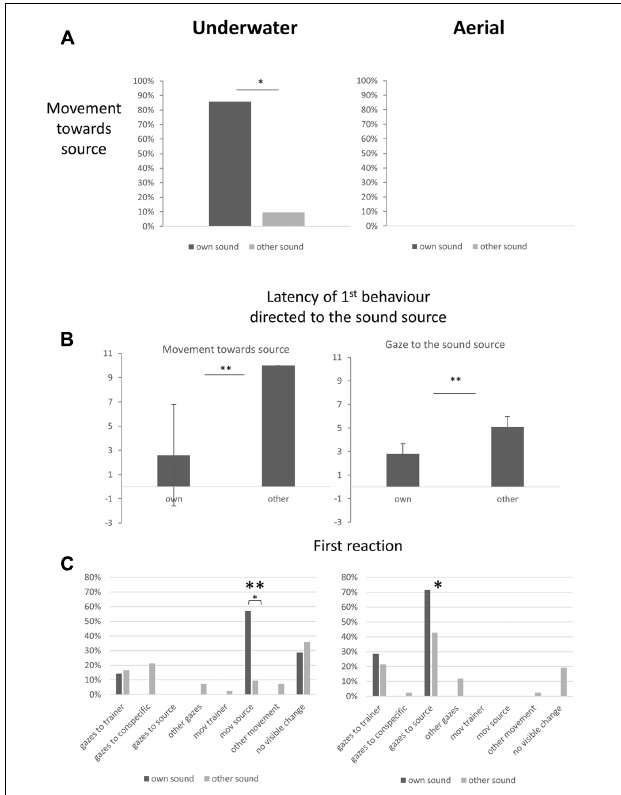
FIGURE 2 | Dolphin reactions to their own individual sound cue and to other sound cues broadcast underwater (left) and in the air (right). (A) Movements of dolphins toward the sound source (percentage of subjects; binomial test on real numbers, ∗ P < 0.05). (B) Latencies of first reactions to the sound: movement when the sound was underwater and gaze when it was airborne; mean ± standard error (Wilcoxon test, medians of latencies per subject for other individual-specific sound cues versus own sound cue, ∗∗ P < 0.01). (C) Dolphins’ first reactions to a broadcast (percentage of subjects). One behavior predominated in each situation: movement toward the source of the underwater sound, gaze toward the source of the airborne sound (chi-square test performed on real numbers, ∗ P < 0.05, ∗∗ P <